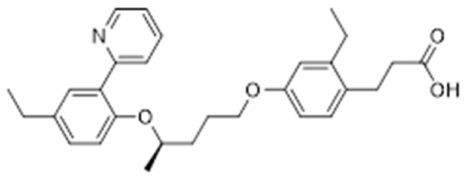
Figure 12. Chemical structure of a PPAR- γ / δ